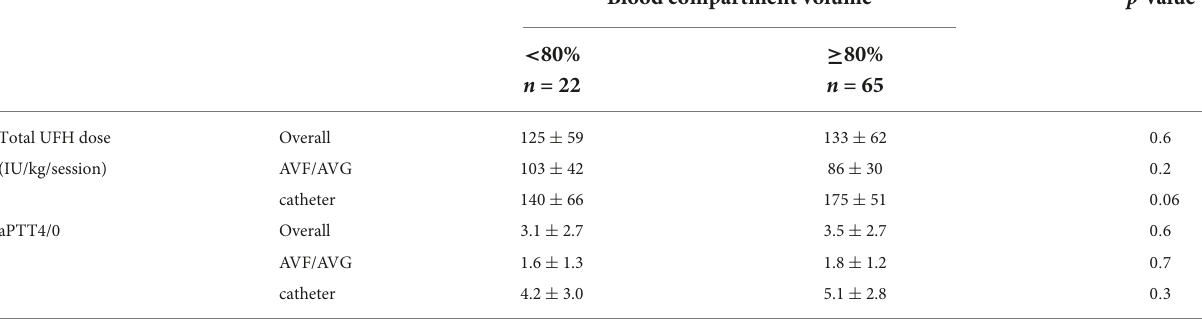
TABLE 7 Total UFH dose and aPTT4/0 ratios according to blood compartment volume